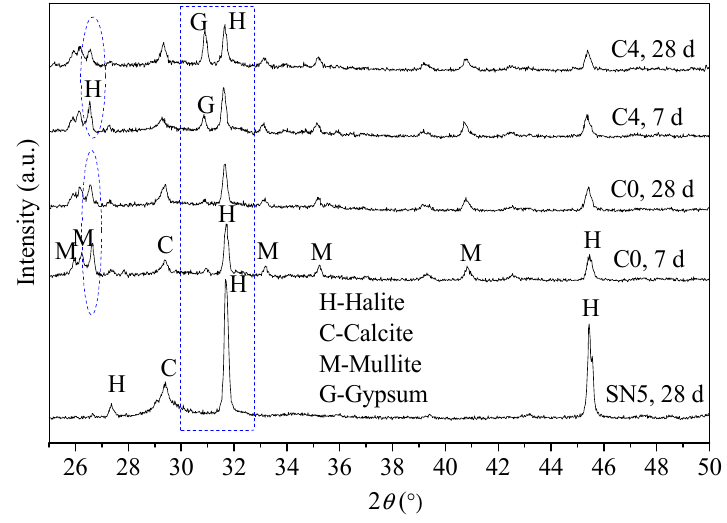
Figure 5. Mineral phases of control C0 (SR-FFA-NS system) and paste C4 (SR-FFA-BHG-NS system) at 7 d and 28 d.